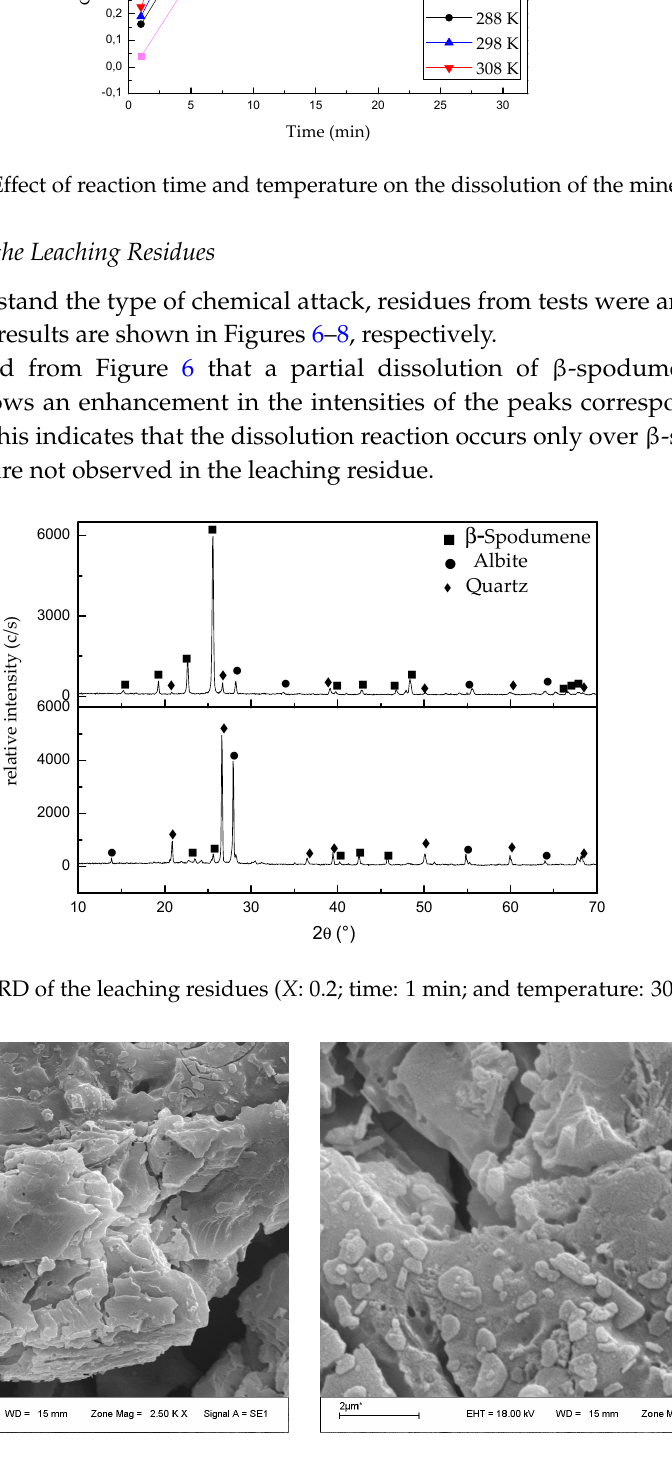
Figure 7. SEM micrographs of the leaching residue ( X : 0.04; time: 1 min; and temperature: 278 K).